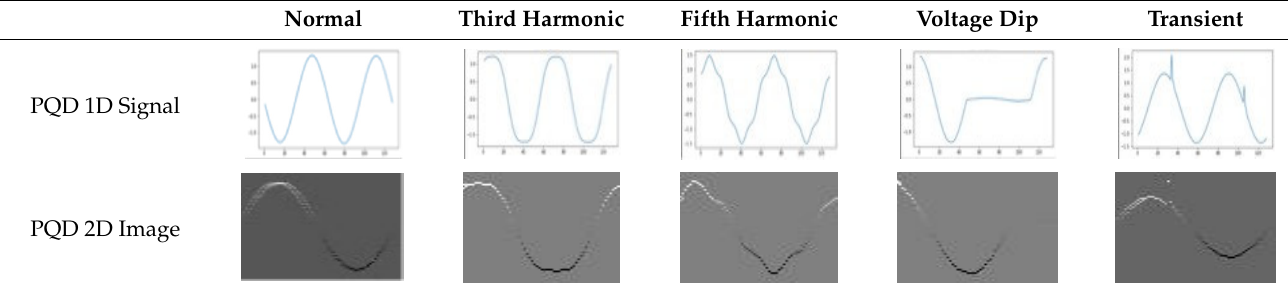
Table 2. Power-quality-disturbance signal form and 2D grayscale image.